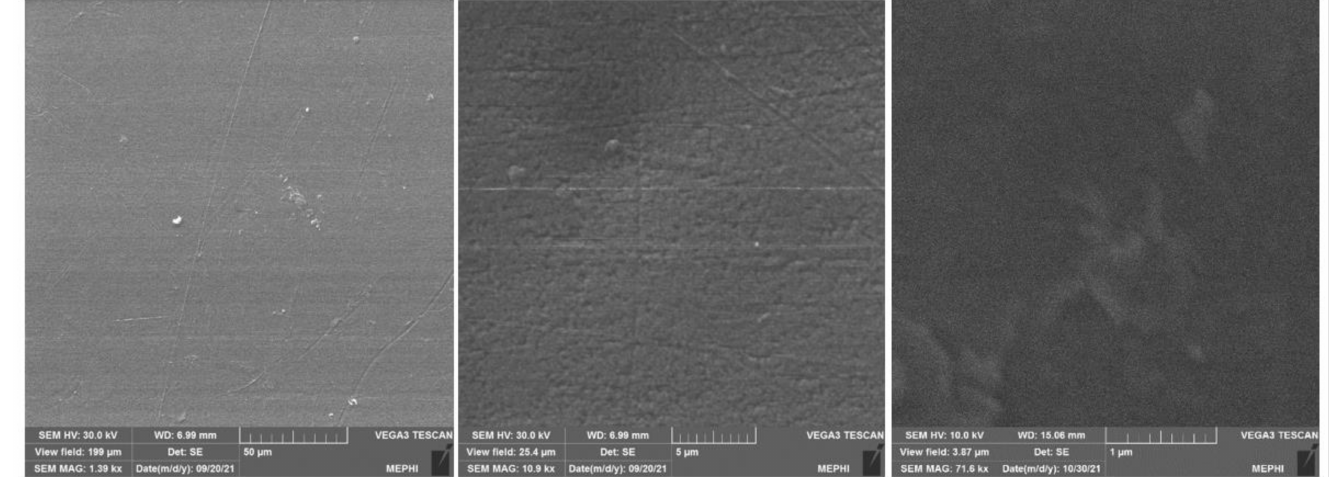
Figure 5. SEM images of a ZnO coating surface with a deposited Ag layer at different scales.